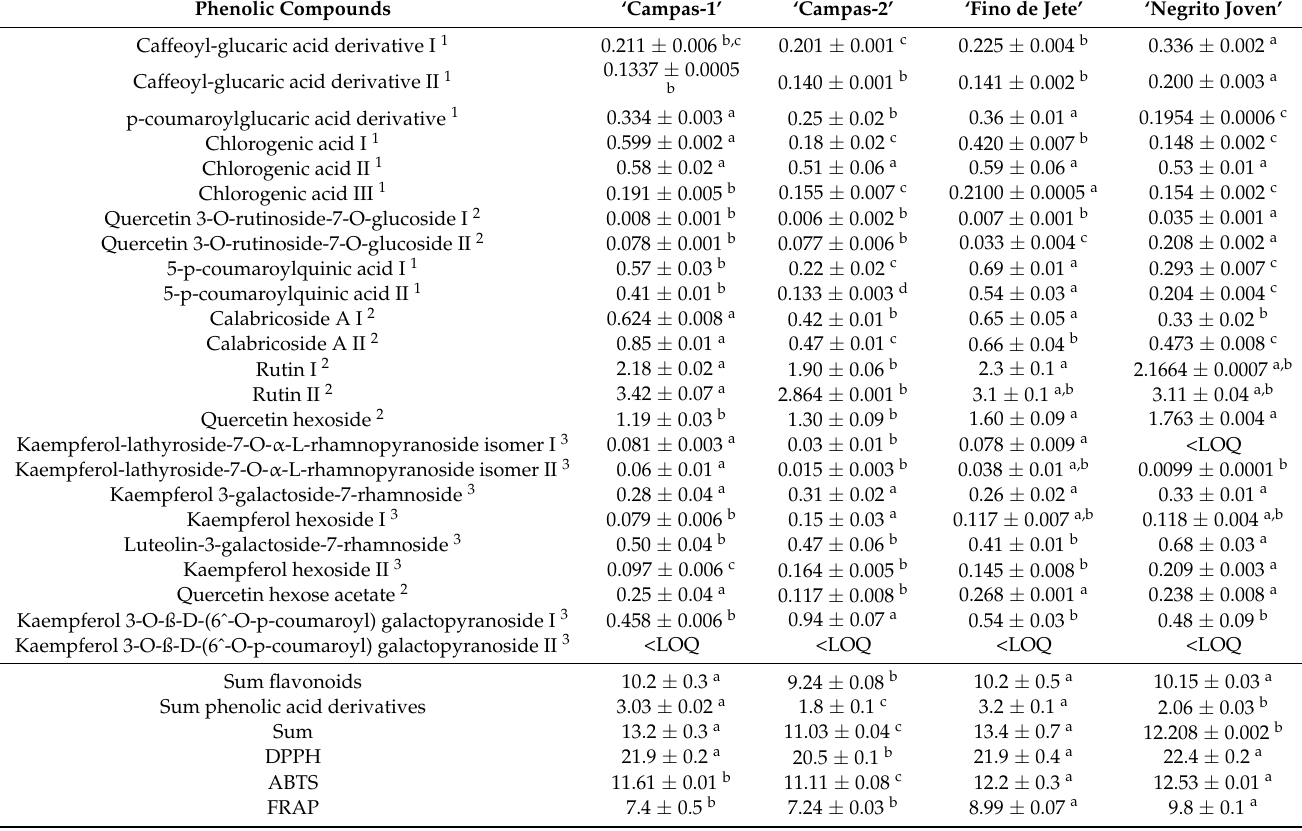
Table 6. Quantification table of phenolic compounds and antioxidant activities in different cultivars of cherimoya leaves obtained at optimum UAE sonotrode